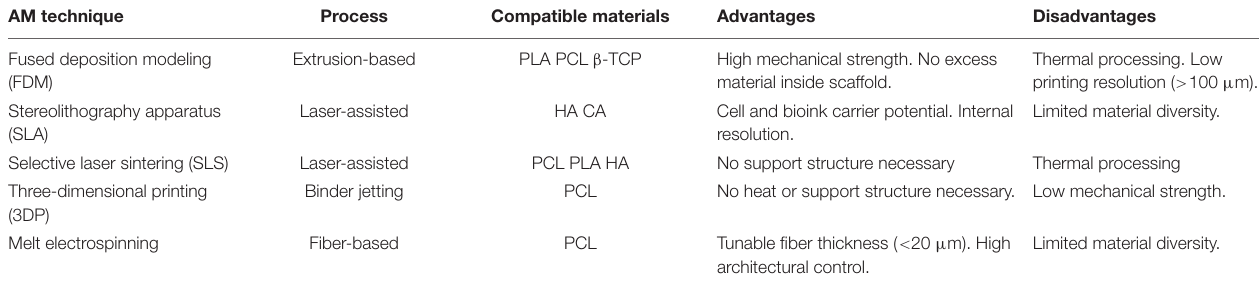
TABLE 1 | Types of additive manufacturing processes and their general features.